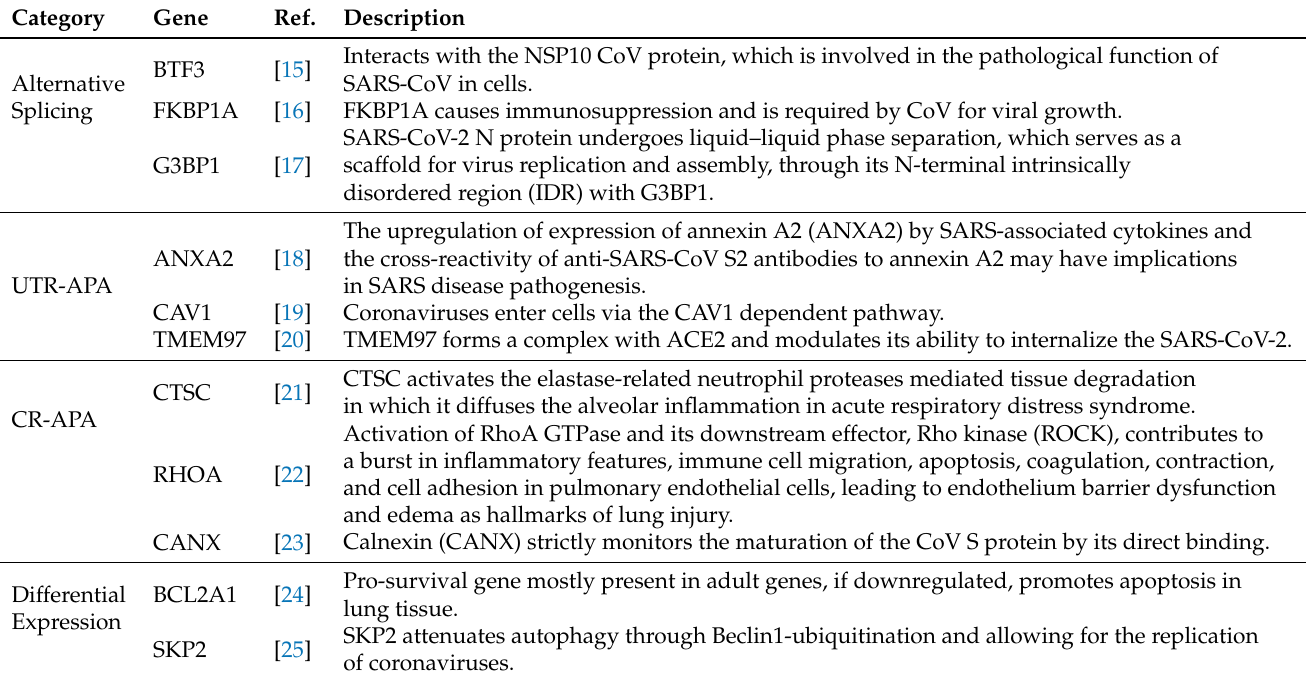
Table 3. Literature review of identified genes with transcript variants and their implication on SARS-CoV-2 pathogenesis and